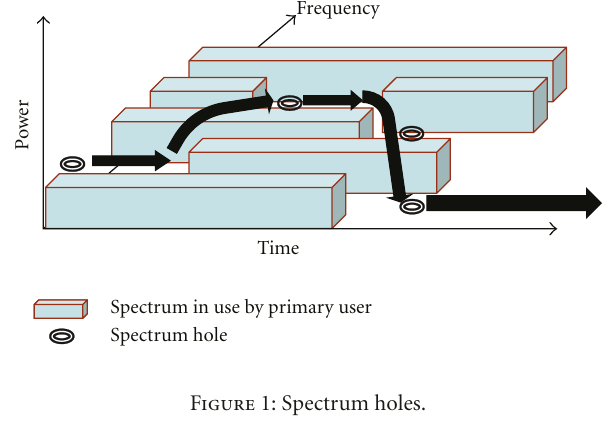
Figure 1: Spectrum